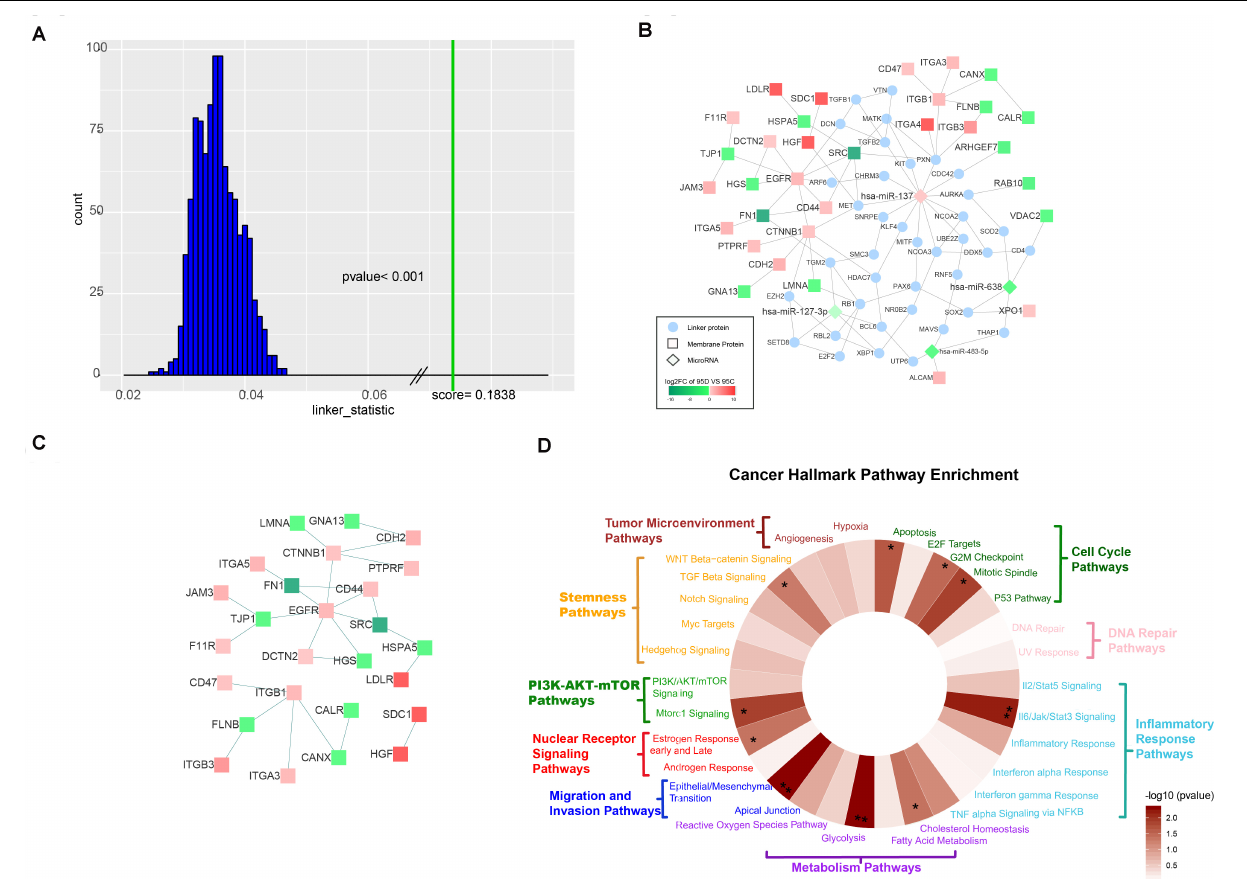
FIGURE 2 | Characterization of the TieDIE network. (A) The distribution of background scores and real score. The distribution of background scores is shown as blue bars, while the green line represents the real score. (B) Compact subnetwork after manually deleting linker proteins whose degree was one from the raw subnetwork constructed by the TieDIE program. The rhombus nodes represent for microRNAs, the circle nodes represent for linker proteins, while the square nodes represent differentially expressed membrane proteins. The node color changes according to the fold change values. (C) PPI subnetwork of 32 differentially expressed membrane proteins. (D) Wheel plot of cancer hallmark enrichment of the TieDIE